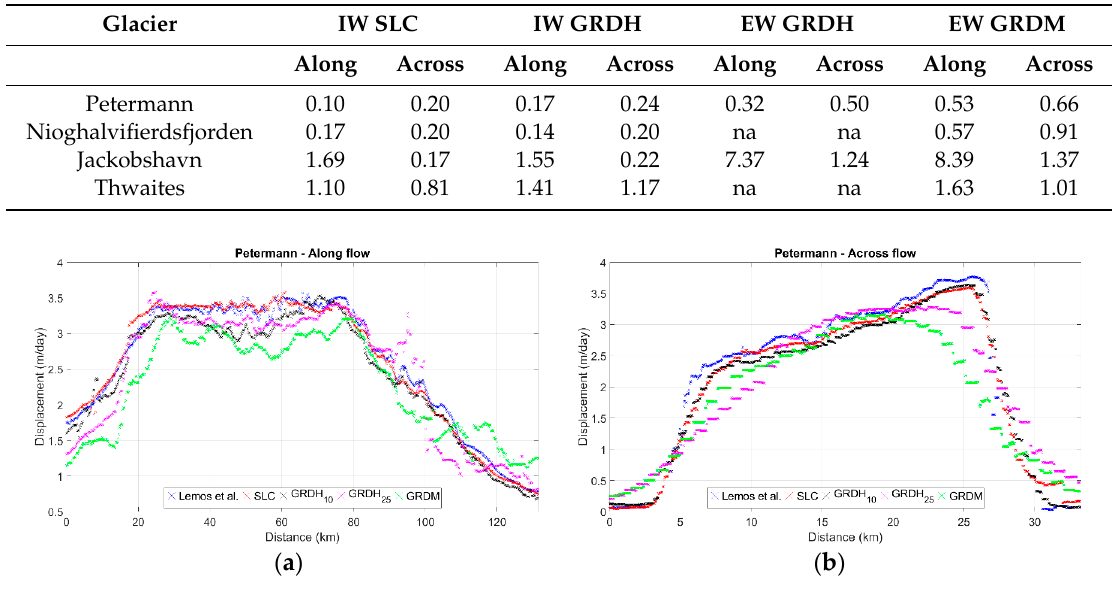
( b ) Figure 8. JAK, average annual flow speed for reference data (blue curve) and all the analyzed products (IW SLC red curve, IW GRDH black curve, EW GRDH magenta curve, EW GRDM green curve). ( a ) Along flow speed. ( b ) Across flow speed. As for NI, the displacement velocity estimated using EW GRDH products is not fitting the reference distribution, as shown in Figure 7a,b. This is also confirmed by the RMSE values reported in Table 12, which are higher with respect to those calculated for IW SLC and IW GRDH images. As a general comment, the reference curves for the flow velocity for the along and across flow transects are almost in the middle of those retrieved using these products, with those relevant to IW SLC images placed slightly upper. In the case of JAK, the differences between reference data and the results obtained by processing IW SLC and IW GRDH images are concentrated in the along flow direction, with particular reference to the first kilometers of the considered transect (see Figure 8a). Concerning the